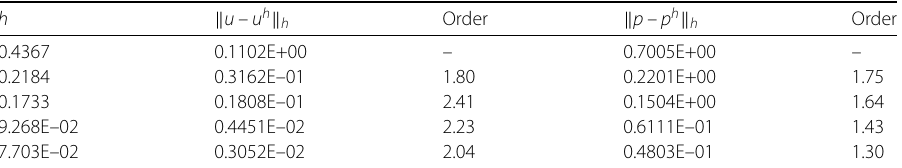
Table 2 Table of errors and order of convergence